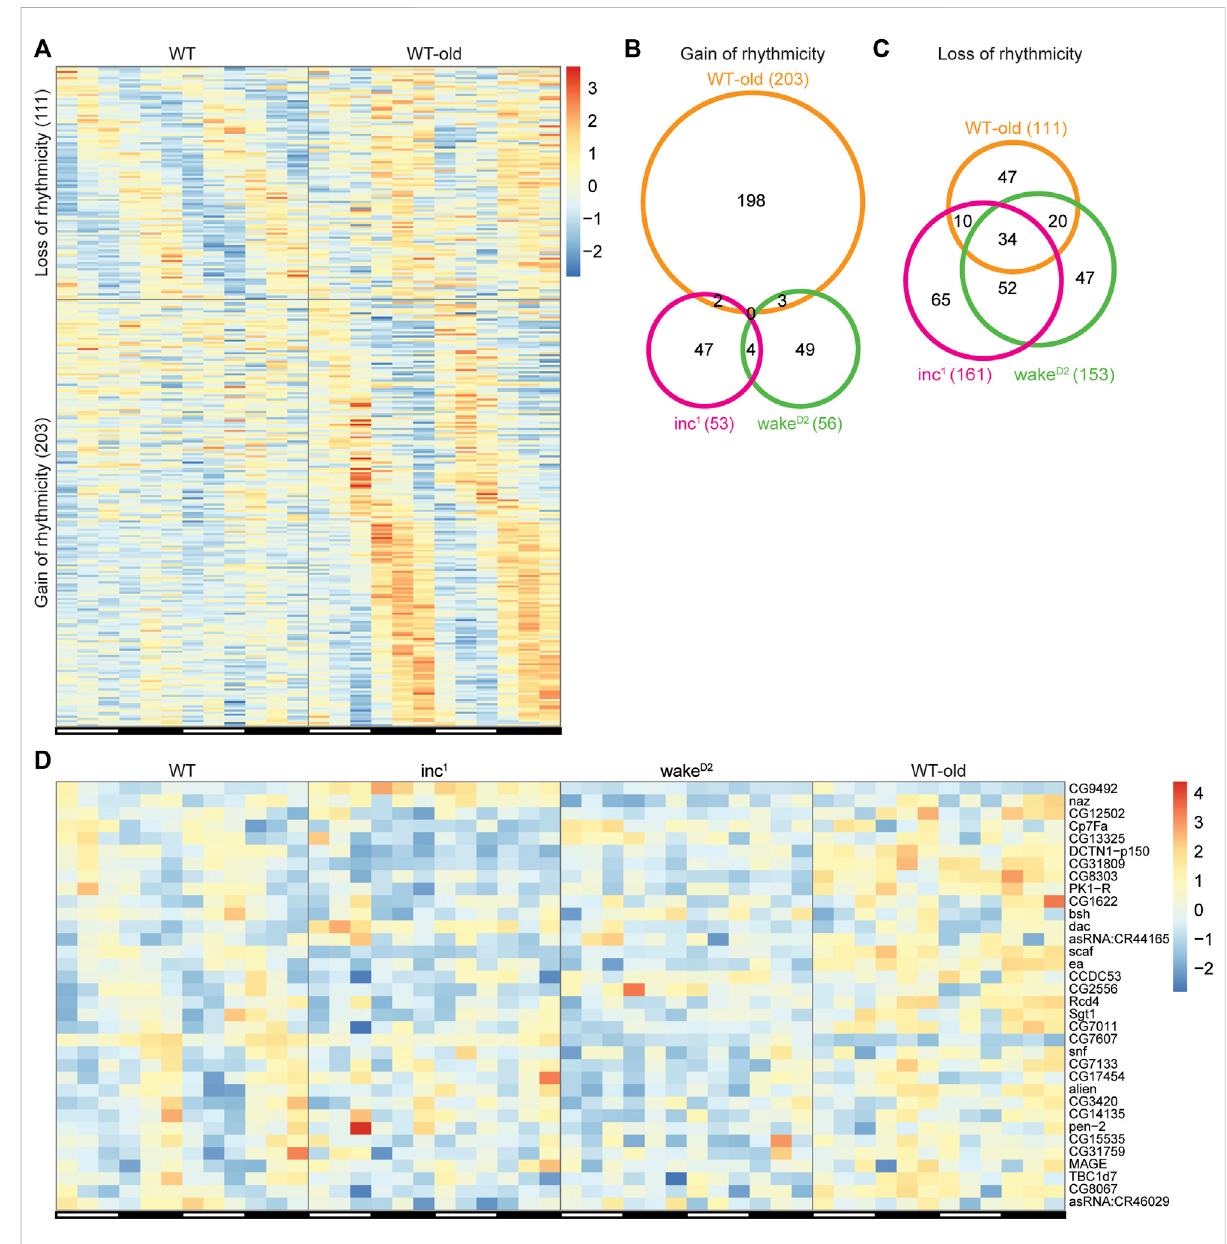
FIGURE 6 Shared rhythmicity changes across chronically sleep deprived fl ies and old fl ies. (A) Genes with rhythmicity change in WT-old . Each row representsonegene,andeachcolumnrepresentsonetimepoint.Expressionlevelsarenormalizedtoeachgeneitselfanddataarealignedaccording to the peak expression time in the highly rhythmic group calculated by JTK cycle. The blocked horizontal bars below the panel correspond to the light-dark cycle. (B,C) Intersection of gain of rhythmicity genes (B) and loss of rhythmicity genes (C) in inc 1 (magenta), wake D2 (green), and WT- old (orange). (D) Heatmap of the 34 intersected genes in (C) . Each row represents one gene, and each columnrepresents one timepoint. Expression levels are normalized to each gene itself and data are aligned according to the peak expression time in WT group calculated by JTK cycle. The blocked horizontal bars below the panel correspond to the light-dark